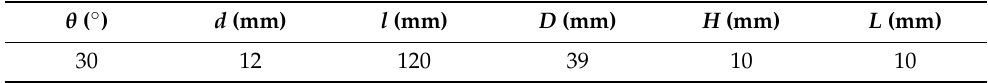
Table 1. Preliminary parameters design of sampling structure.